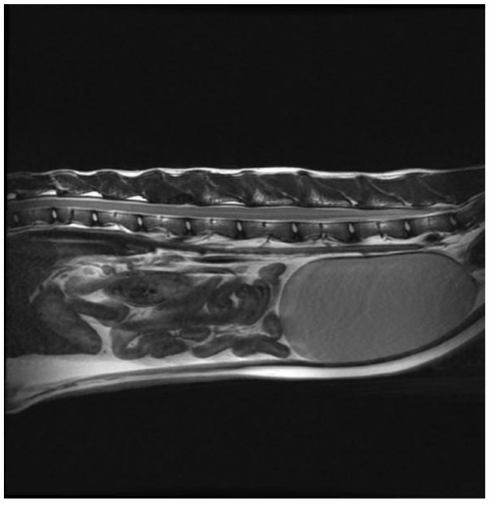
Figure 8. Sagittal T2W image of the spinal cord performed on 22 January 2022 showing no extradural and no epaxial